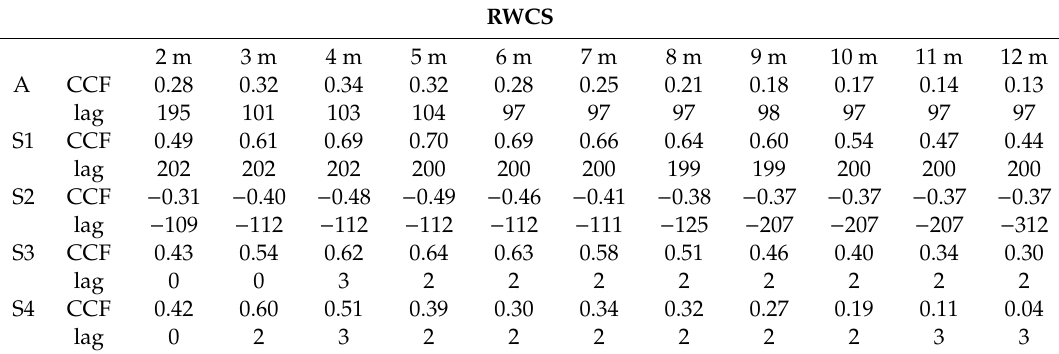
Table 1. Cross-correlation coefficient (CCF) and the lag number between the RWCS of each layer and the surface chlorophyll a concentration. A: all data during the study period. (a lag number of 1 represents 15 min). RWCS 2